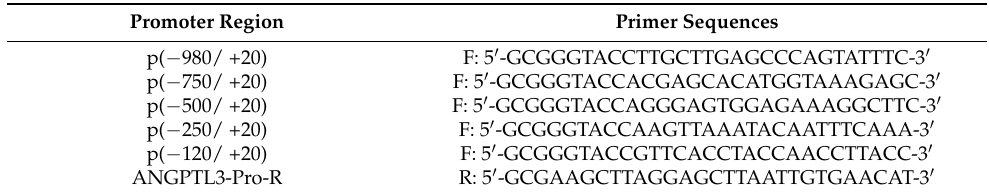
Table 2. Primer pairs used in construction of plasmids contained ANGPTL3 promoter DNA region. Promoter